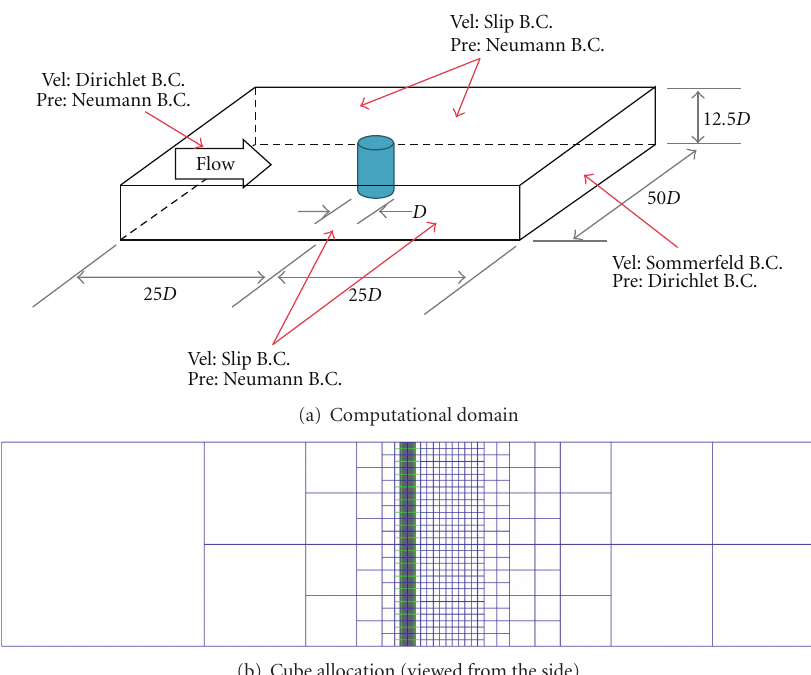
Figure 3: Computational domain with boundary conditions and Cube allocation.